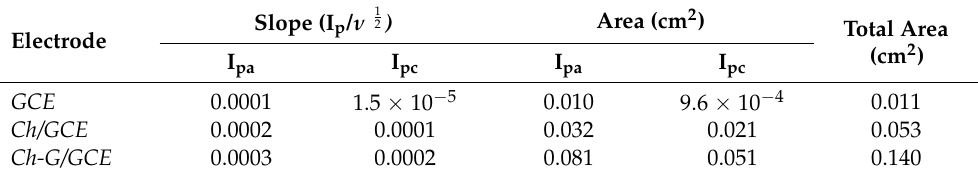
Table 1. Surface active areas of GCE , Ch/GCE , and Ch-G/GCE electrodes.